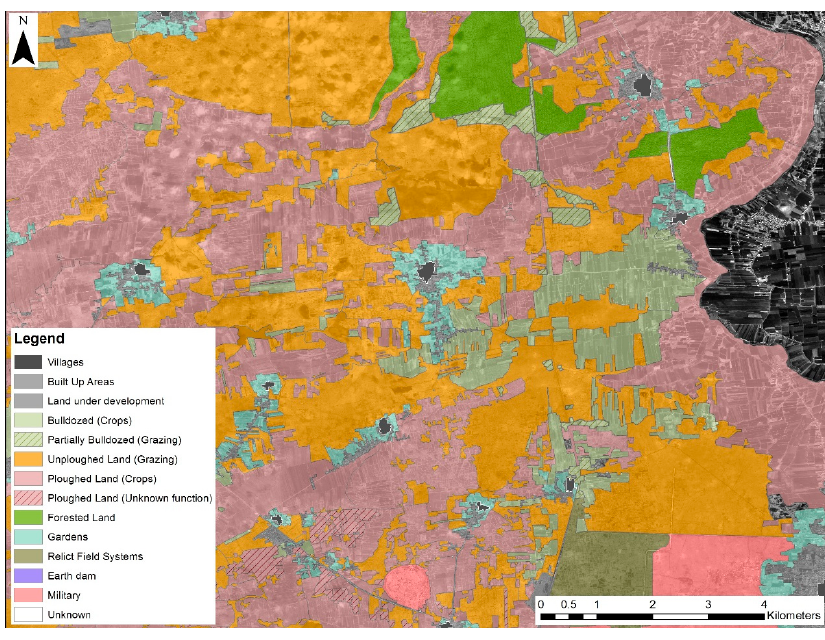
Figure 13. Modern landuse practices based on an assessment of Ikonos panchromatic imagery, acquired 2 March 2002.